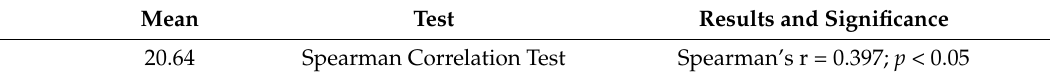
Table 4. Results of association tests between author-related variables and number of